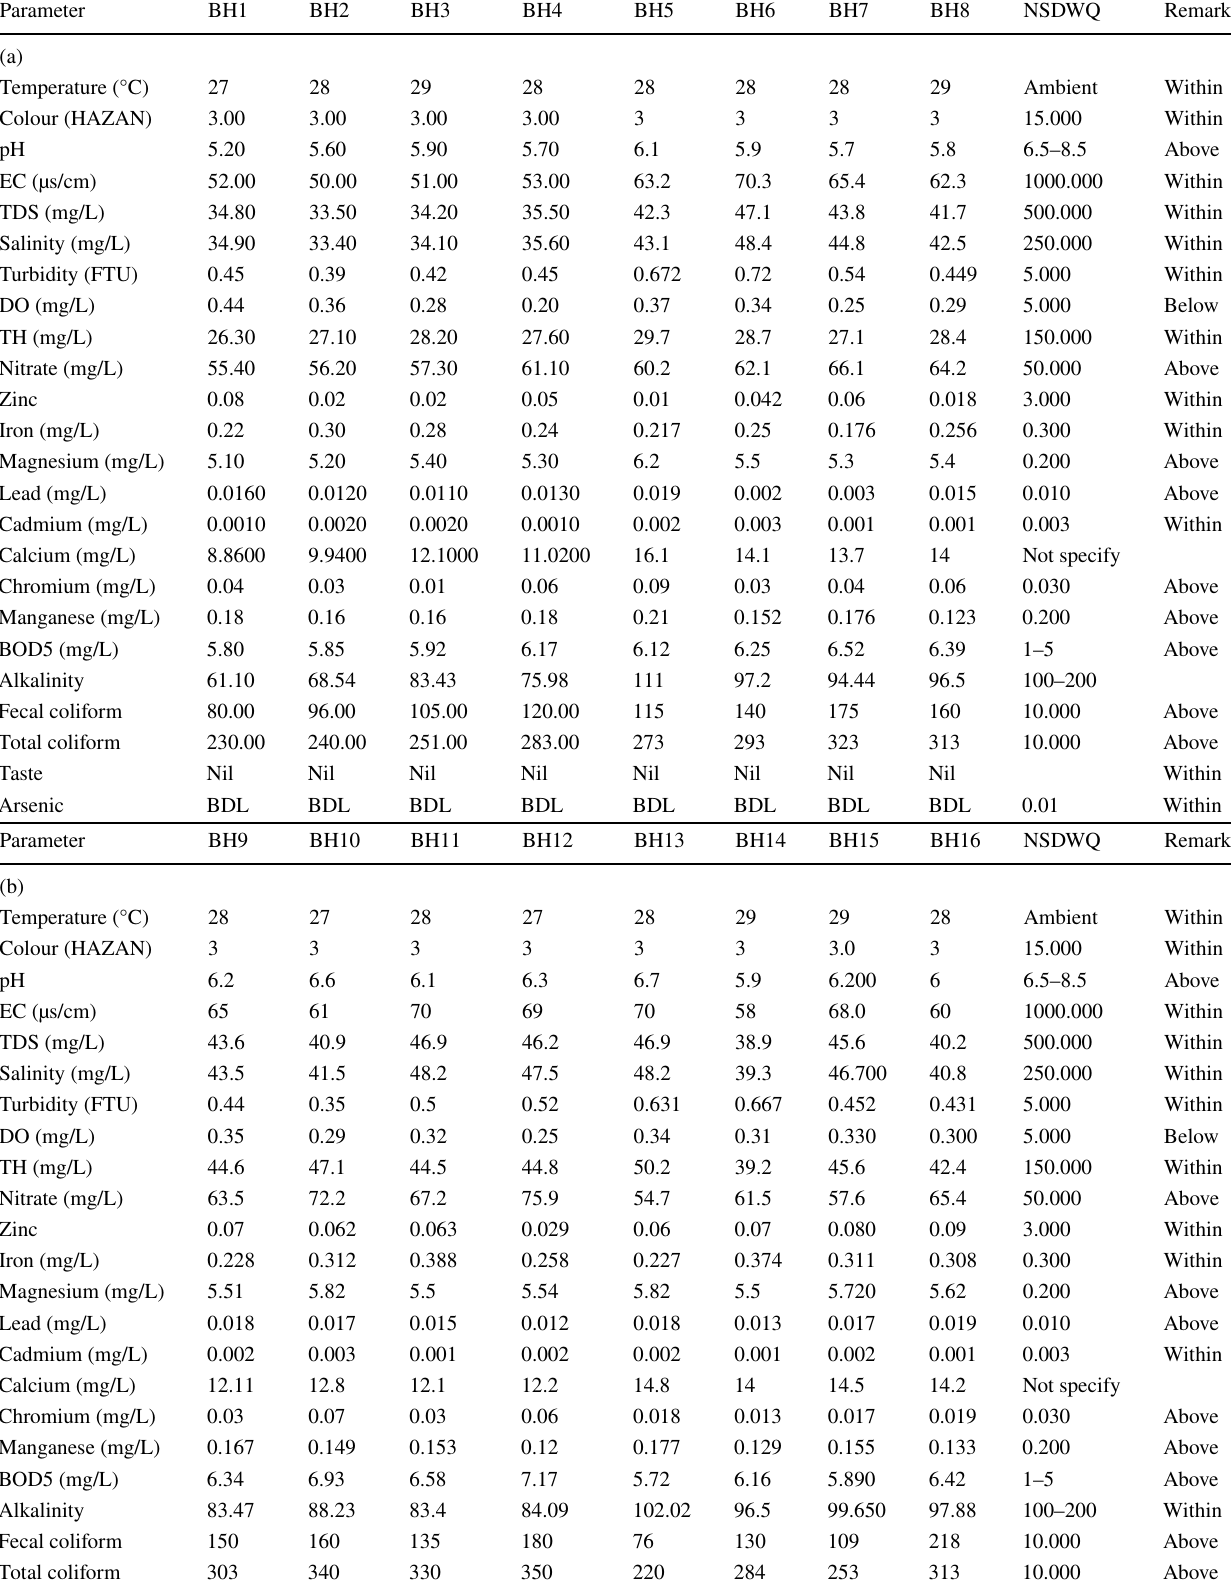
Table 3 Physicochemical parameter of borehole water in